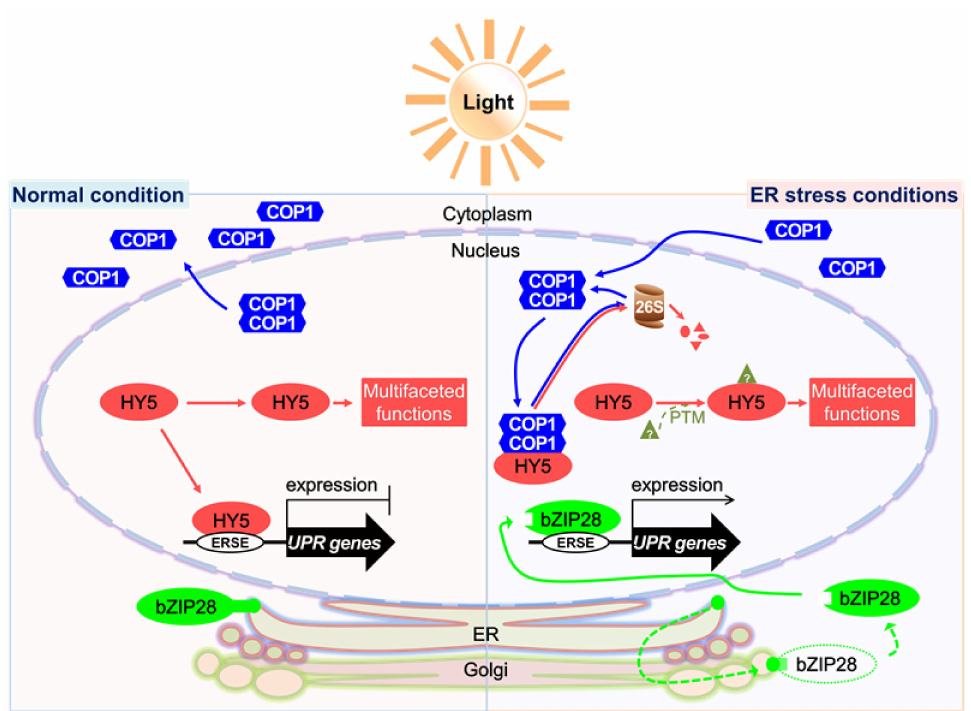
Figure 7. Model depicting the role of COP1 in ER stress. Under normal light conditions, activated photoreceptors perceive the light signals and mediate the translocation of COP1 from the nucleus to the cytoplasm, while simultaneously promoting downstream light signaling components such as HY5, which displays multifaceted roles. HY5 also occupies the promoters of UPR genes and suppresses their expression. Under ER stress conditions, COP1 is enriched in the nucleus, where it mediates the partial degradation of HY5 via the 26S proteasome. This in turn allows the truncated bZIP28 protein to bind to the promoters of UPR genes and to activate their expression, thus enhancing the ER stress resistance of plants. Blue, red and green lines express movements of COP1, HY5 and bZIP28,